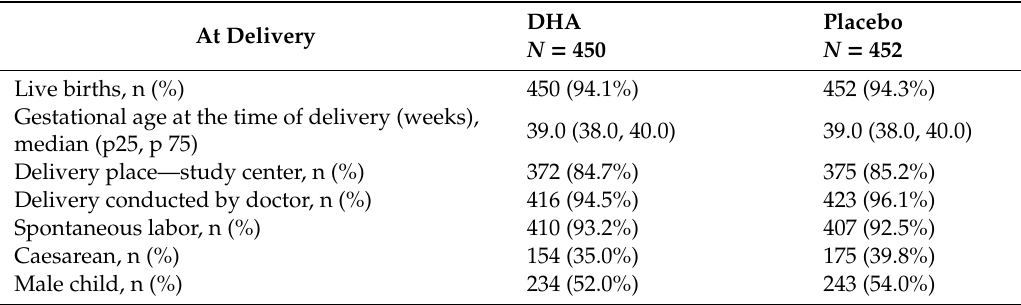
Table 2. O ff spring characteristics at delivery.